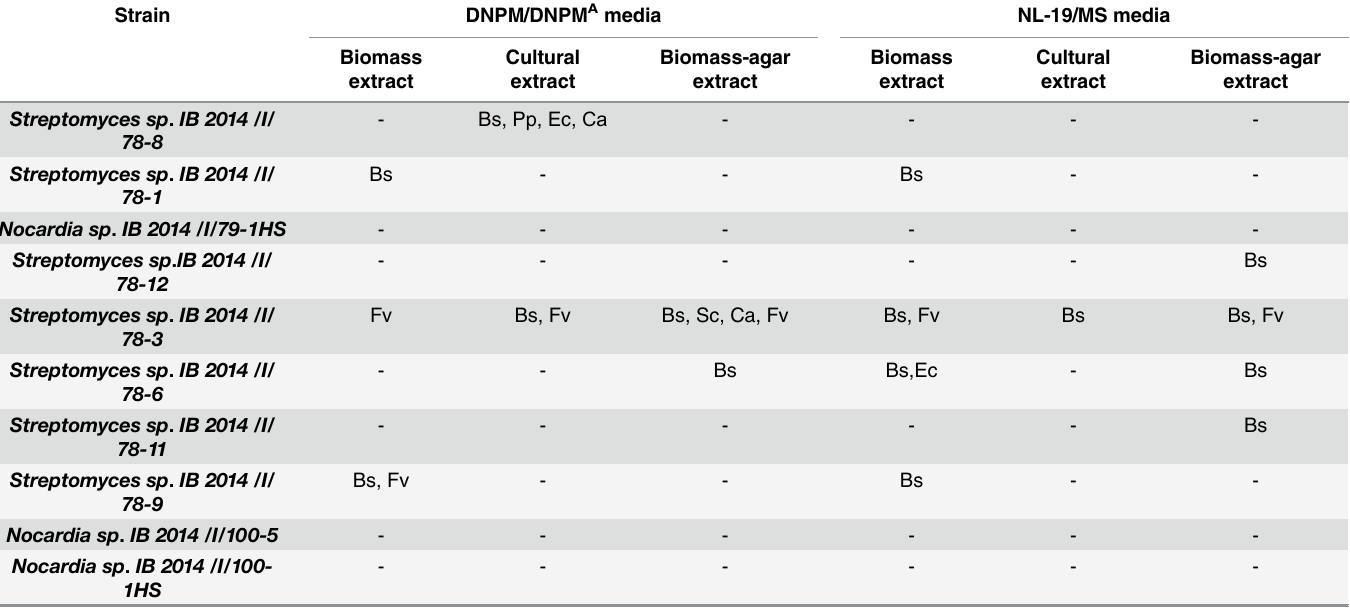
Table 2. Antimicrobial activity of isolated strains when grown on different